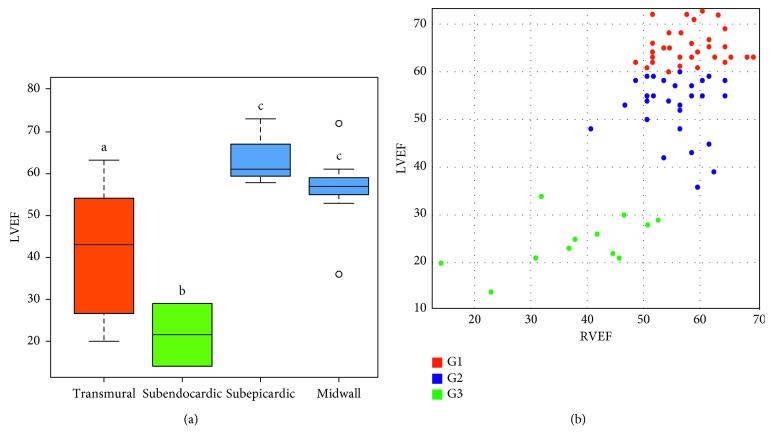
(a) LVEF of different LGE distributions and (b) scatterplot of LVEF and RVEF between groups (rs=0.69).